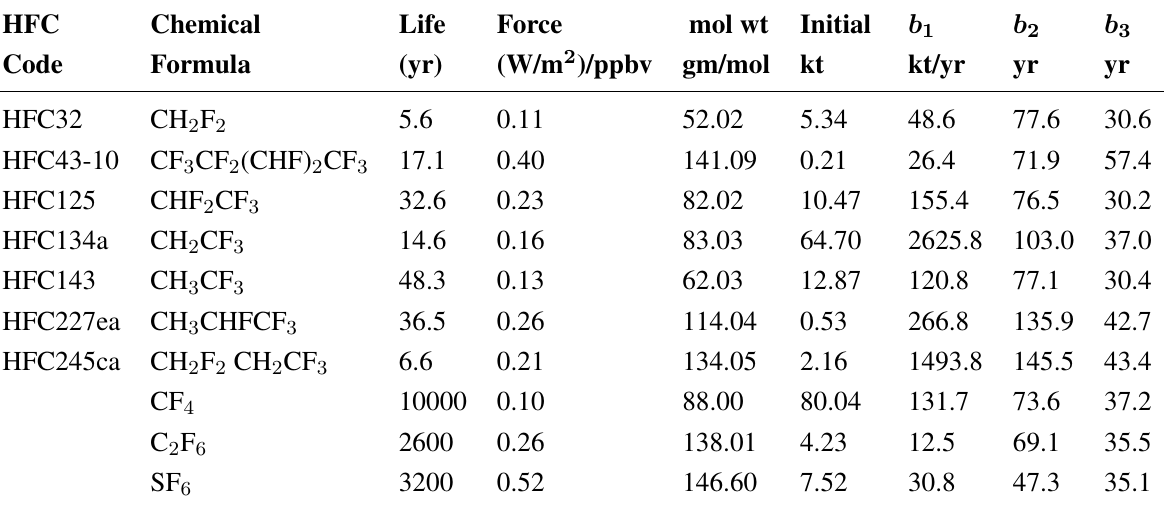
Table 5. Parameters for volatile fluorine compounds.